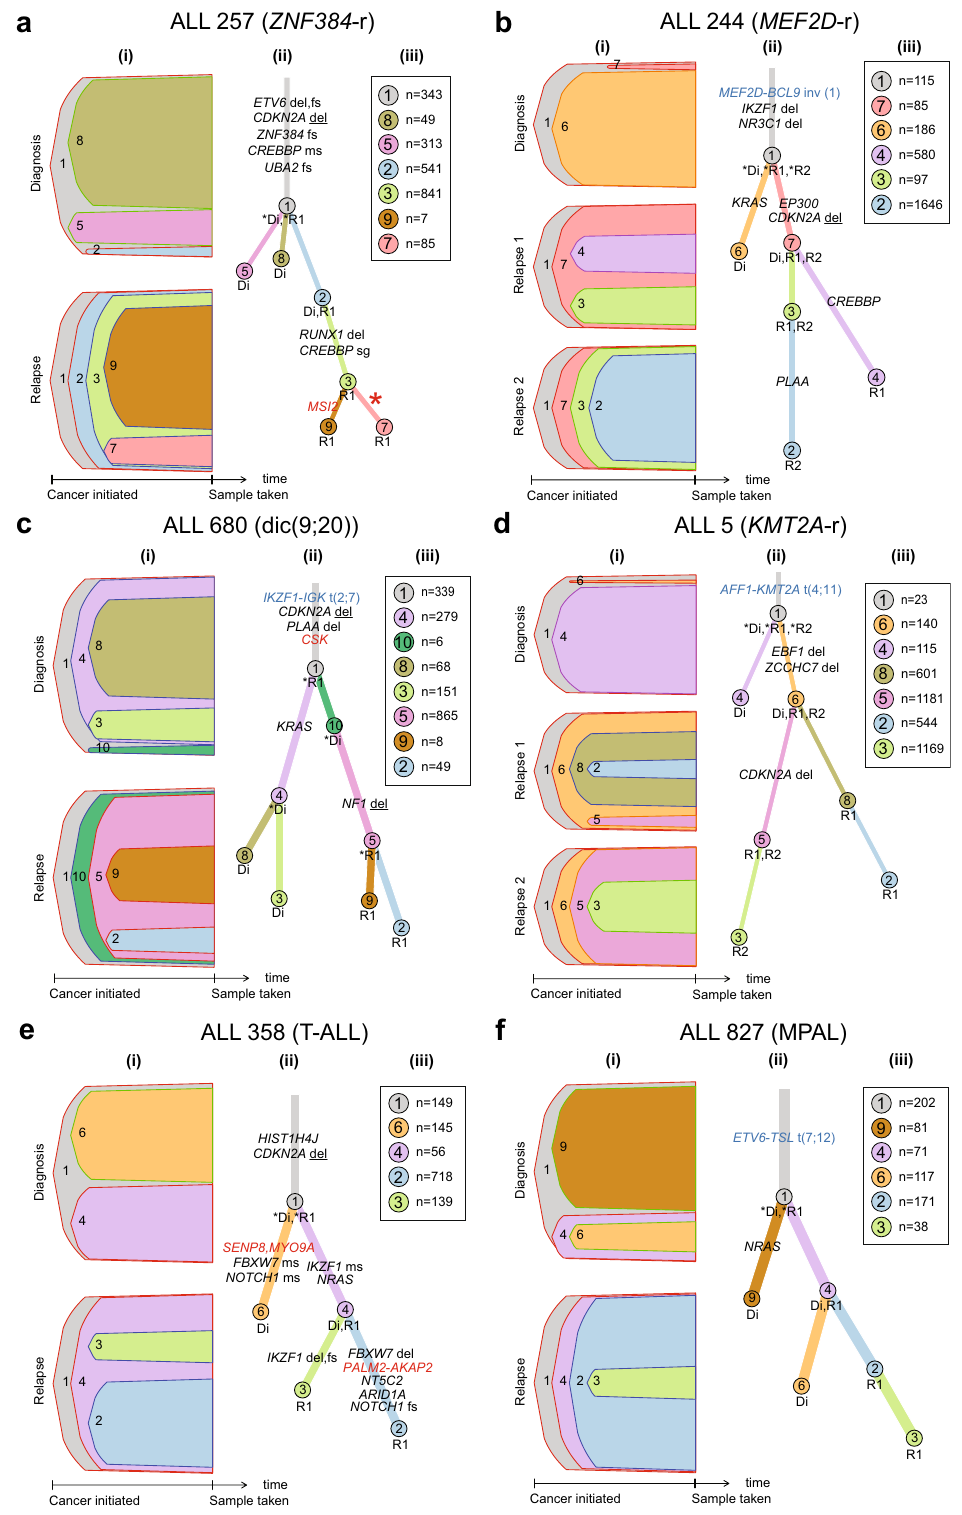
Figure 6. Clonal evolution from diagnosis to relapse for six representative ALL patients with the “rising clone trajectory”. (a) Consensus model for clonal evolution in BCP-ALL patient ALL_257 with ZNF384 -rearranged (b) BCP_ALL patient ALL_244 with a MED2F -rearranged , (c) patient ALL_680 with the dic(9;20) subtype of BCP-ALL, (d) BCP-ALL patient ALL_5 with the KMT2A -rearranged , (e) T-ALL patient ALL_358, and (f) patient ALL_827 with mixed phenotype acute leukemia (MPAL). The most important putative driver mutations, somatic alterations, including small insertion-deletions, putatively regulatory non-coding mutations, copy number alterations and structural variants are shown on the relevant branches of the evolutionary trees. Details and explanations of sections denote (i–iii) are provided in the legend of Fig. 5. Additional details on the evolutionary trajectories are provided in the Supplementary File. ( del homozygous deletion; del heterozygous deletion; fs frameshift; sg stop gain; ms